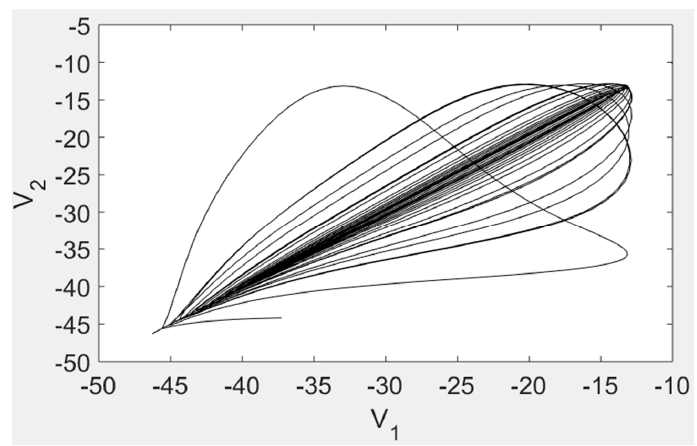
Figure 10. Locus (V 1 , V 2 ) when τ = 2.5 and H syn = 2.7.